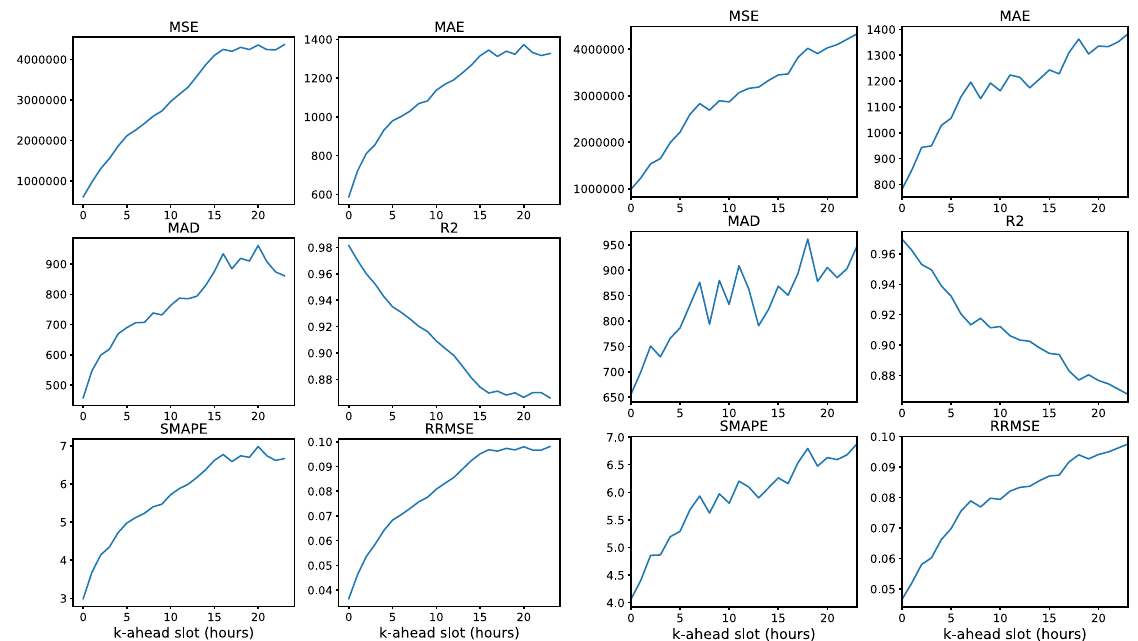
Figure 9. Forecast metrics for successive predicted time-slots for models: ensemble Type II ((1 LSTM + 2 FC) * 2 + (4 FC) * 2) ( 𝑓 = 1, 𝑝 = 168, 𝑘 = 24) ( left ) and DL architecture (2 1D-CNN + 1 LSTM + 1 FC) ( 𝑓 = 1, 𝑝 = 720, 𝑘 = 24) ( right ).